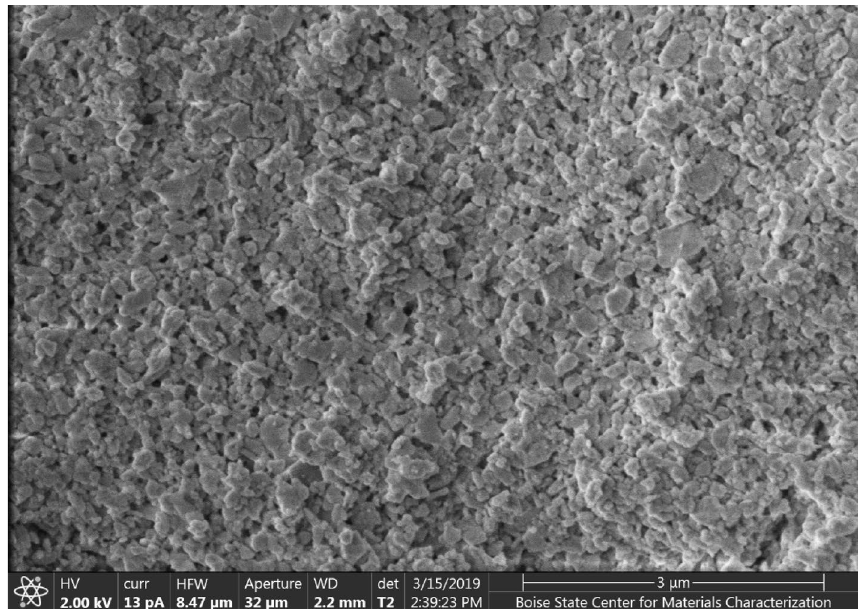
Figure 1. SEM micrograph of nanoparticles. Taken from an as-printed thin